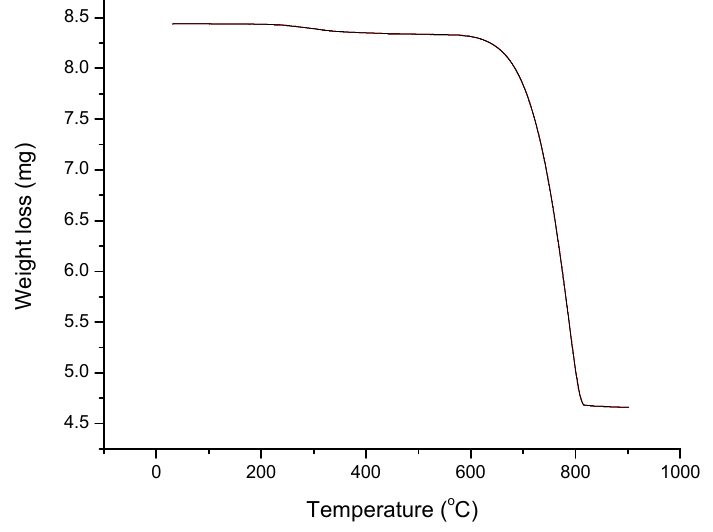
Figure 3. TGA profile of synthesized Chitosan.